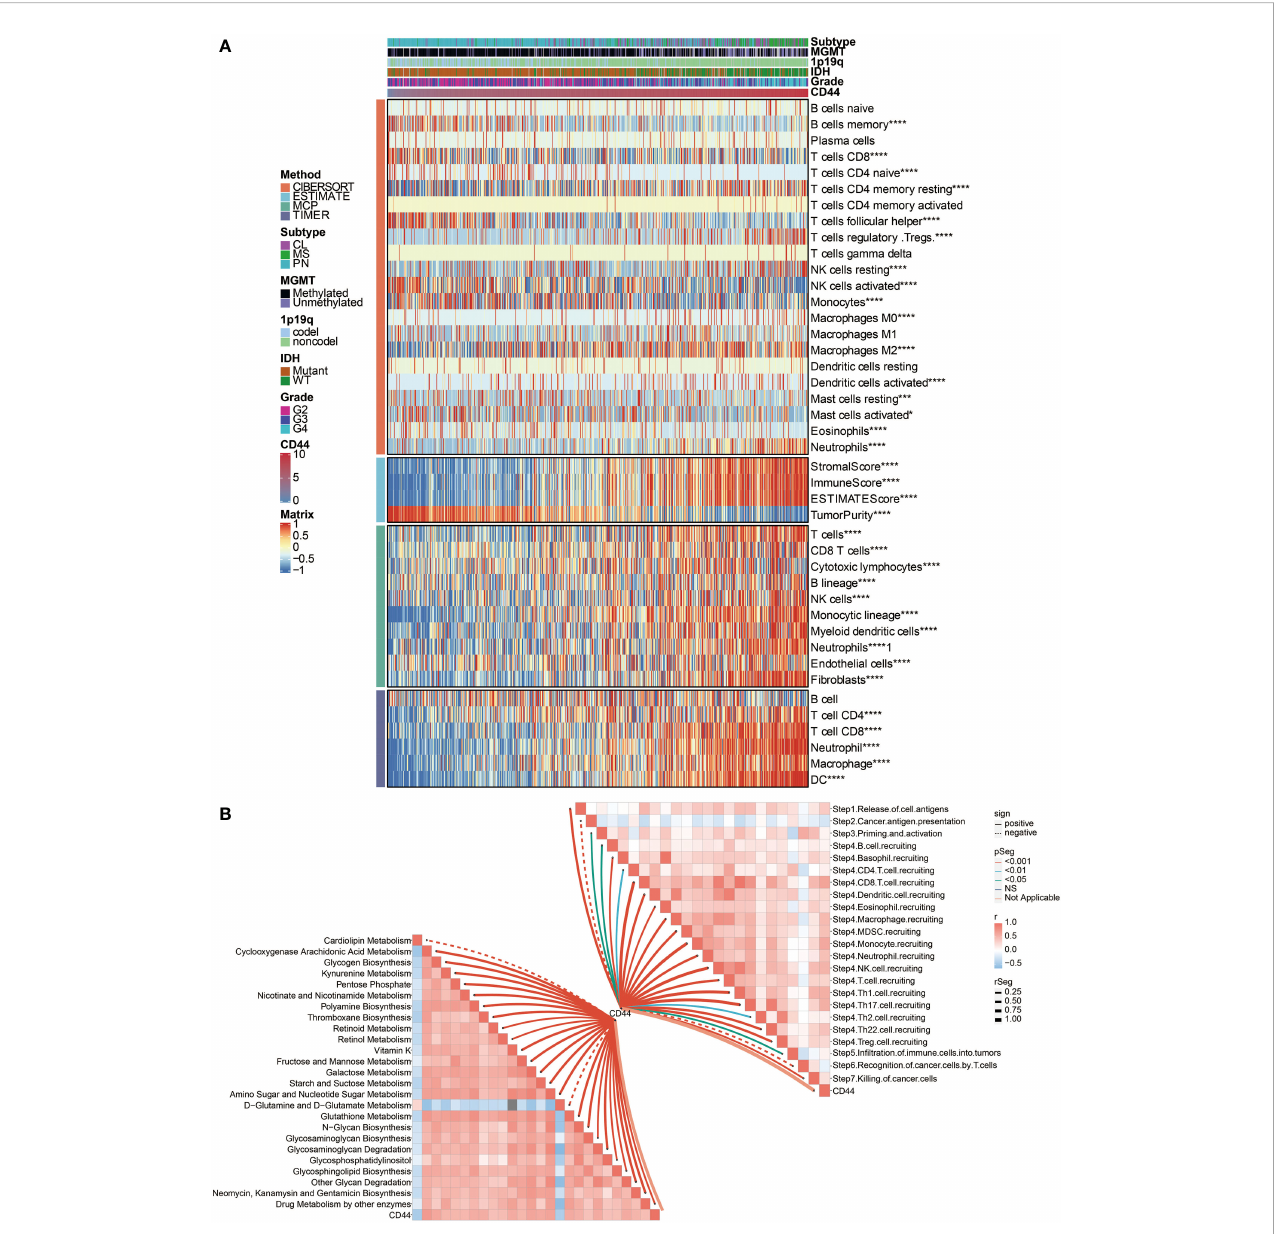
FIGURE 2 Immune processes and metabolism related to CD44 expression. (A) The association between CD44 and immune in fi ltrating cells was estimated by CIBERSORT, ESTIMATE, MCPcounter, and TIMER algorithms. (B) The correlation between CD44 and cancer immunity cycle and metabolic pathways. *, P< 0.05; ***, P<0.001; ****,